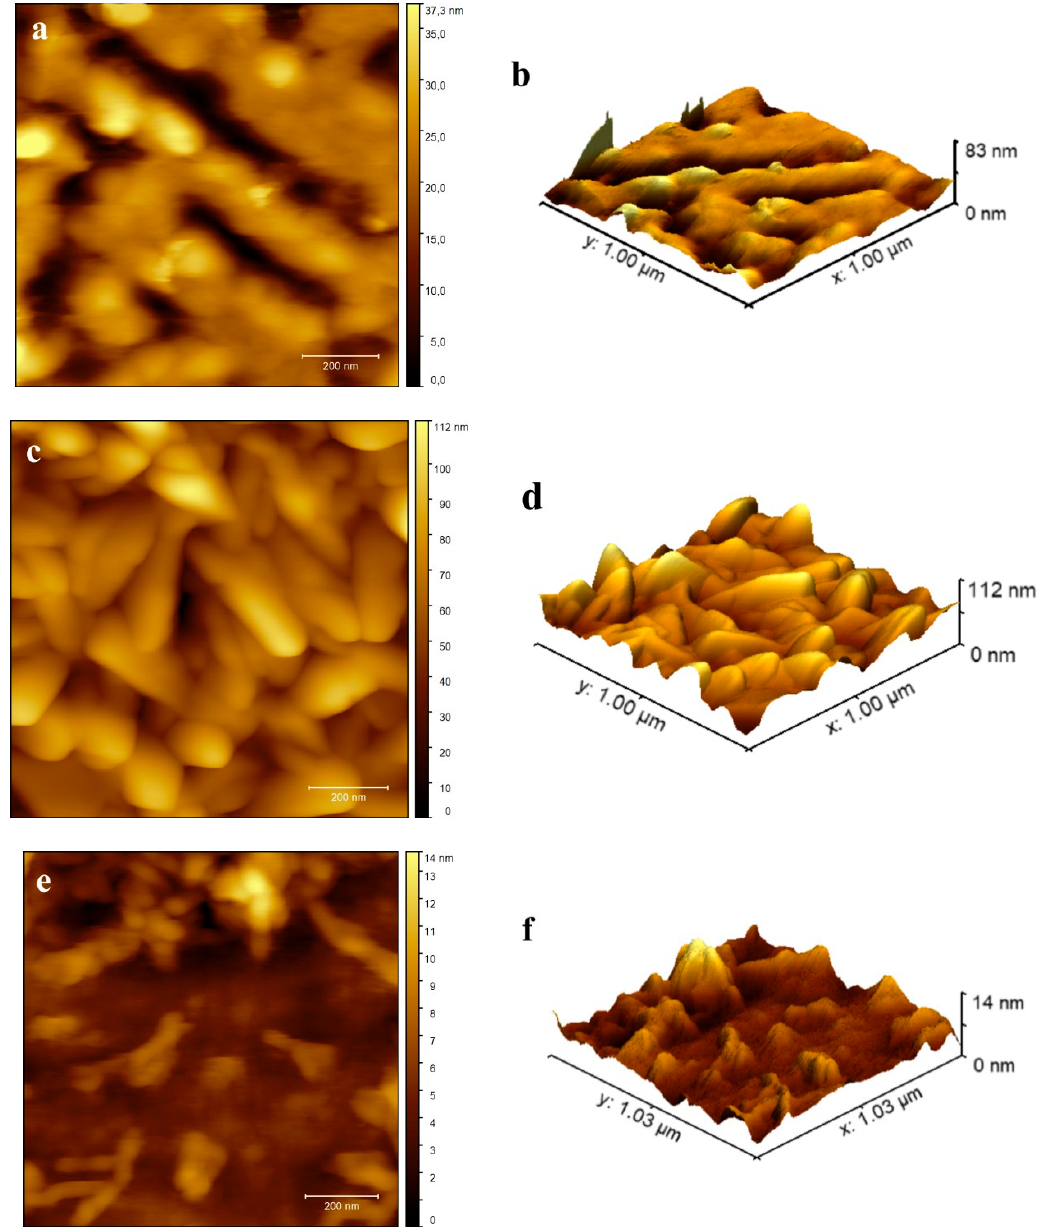
Figure 2. Topography Atomic Force Microscopy (AFM) images of investigated metalorganic complexes thin films: Znq 2 ( a ) 2D and ( b ) 3D, Cuq 2 ( c ) 2D and ( d ) 3D, and Alq 3 ( e ) 2D and ( f ) 3D.